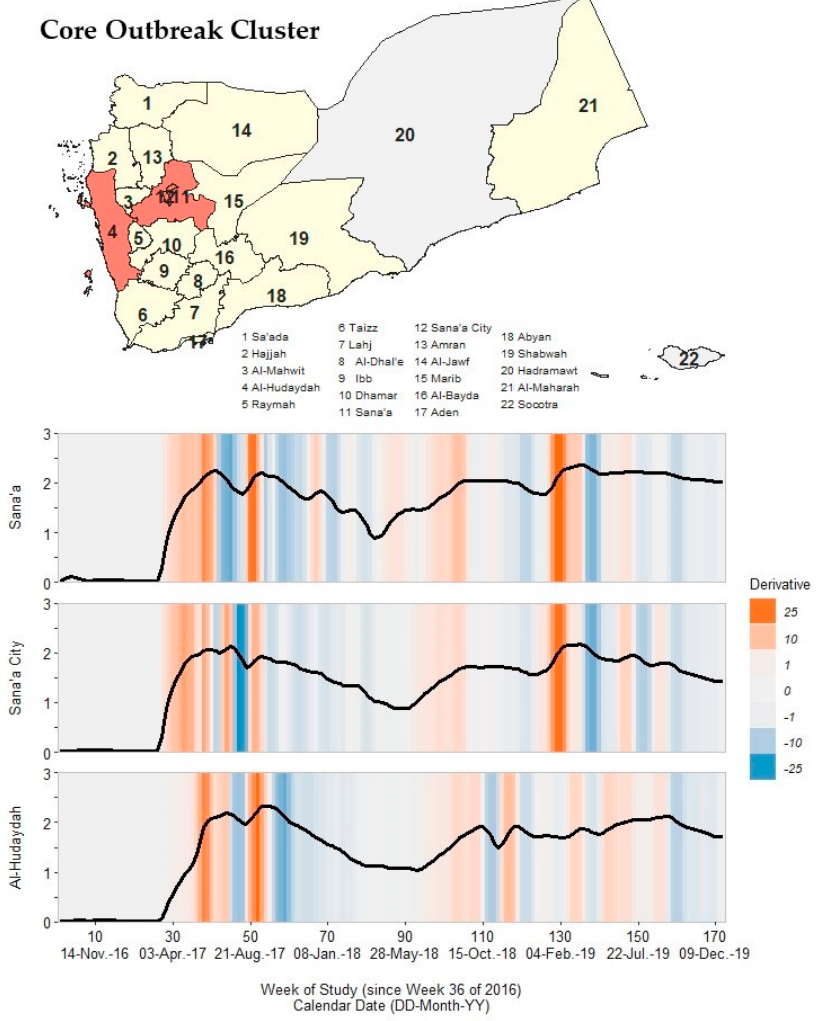
Figure 4. A map of Yemen with a shaded outbreak cluster including Sana’a, Sana’a City, and Al- Hudaydah, and a stacked time series plot and heatmap for each governorate’s outbreak signature. Top panel: the governorate-level map indicates governorates within the cluster in orange, remaining governorates within our study in yellow, and excluded governorates in grey (the Hadramaut and Socotra island governorate). Bottom panel: stacked time series plots for each governorate within the cluster. All plots show log10-transformed smoothed rates produced using Kolmogorov–Zurbenko adaptive filters from Week 36 (4–11 September) of 2016 through Week 52 (23–29 December) of 2019. Smoothed rates (laboratory-confirmed cholera cases per 100,000 persons) were estimated using the best performing smoother. Backgrounds for each plot are heatmaps of trivial derivative values, ranging from − 25 (dark blue) to +25 (dark orange) with values near zero in grey. Time series plots have a common horizontal axis of time reported in weeks since Week 36 of 2016 (defined as study Week 0). Data used to develop this visualization are reported in Table 1 and Supplementary Excel Table S5.